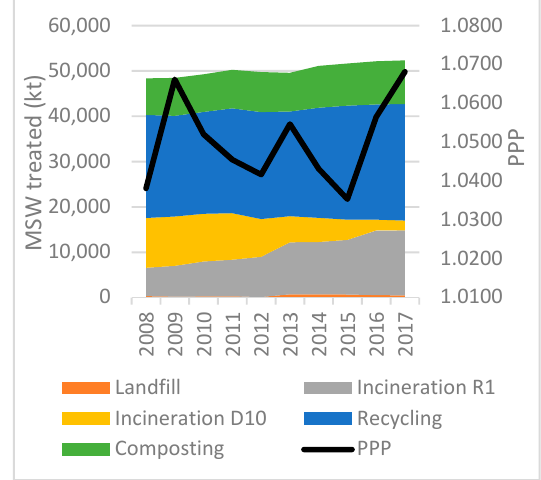
Figure 10. Waste treatment methods and PPP in Germany 2008–2017 (EUROSTAT 2019b, 2019c).